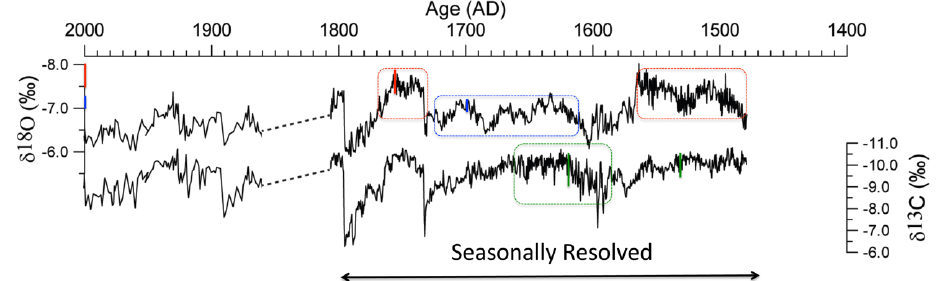
Figure 6. A decrease in δ 18 O seasonality in the drier (and cooler) period between 1610 and 1730 (in blue) indicates lower cave air tempera- ture seasonality than during the wetter (and warmer) periods (1479–1565 and 1730–1770) (in red). Seasonality in the δ 13 C signal is higher between 1600 and 1660 and indicates more intense PCP during summer (in green), which is caused by decreased winter recharge. All values are in ‰